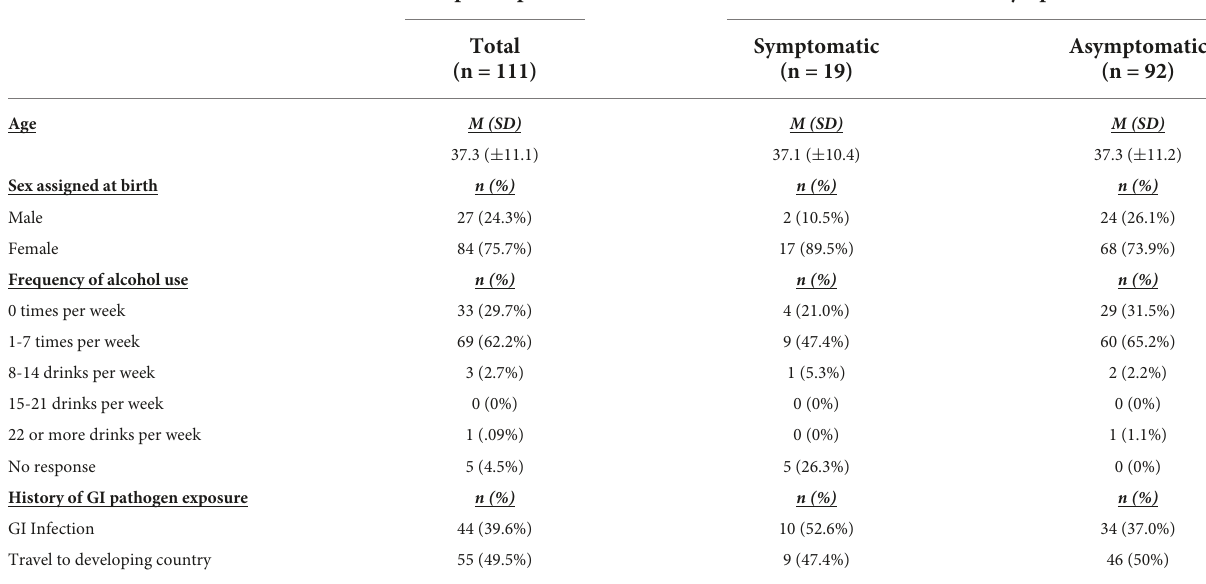
TABLE 1 Baseline characteristics ( n =